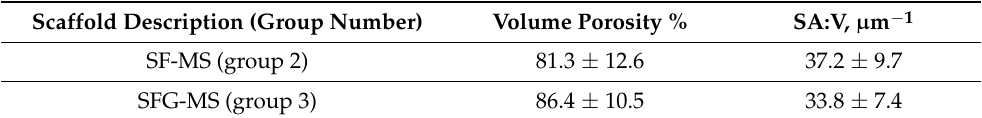
Table 2. The structural parameters of microfibrous scaffolds. Values of the standard deviations for 6 independent measurements are